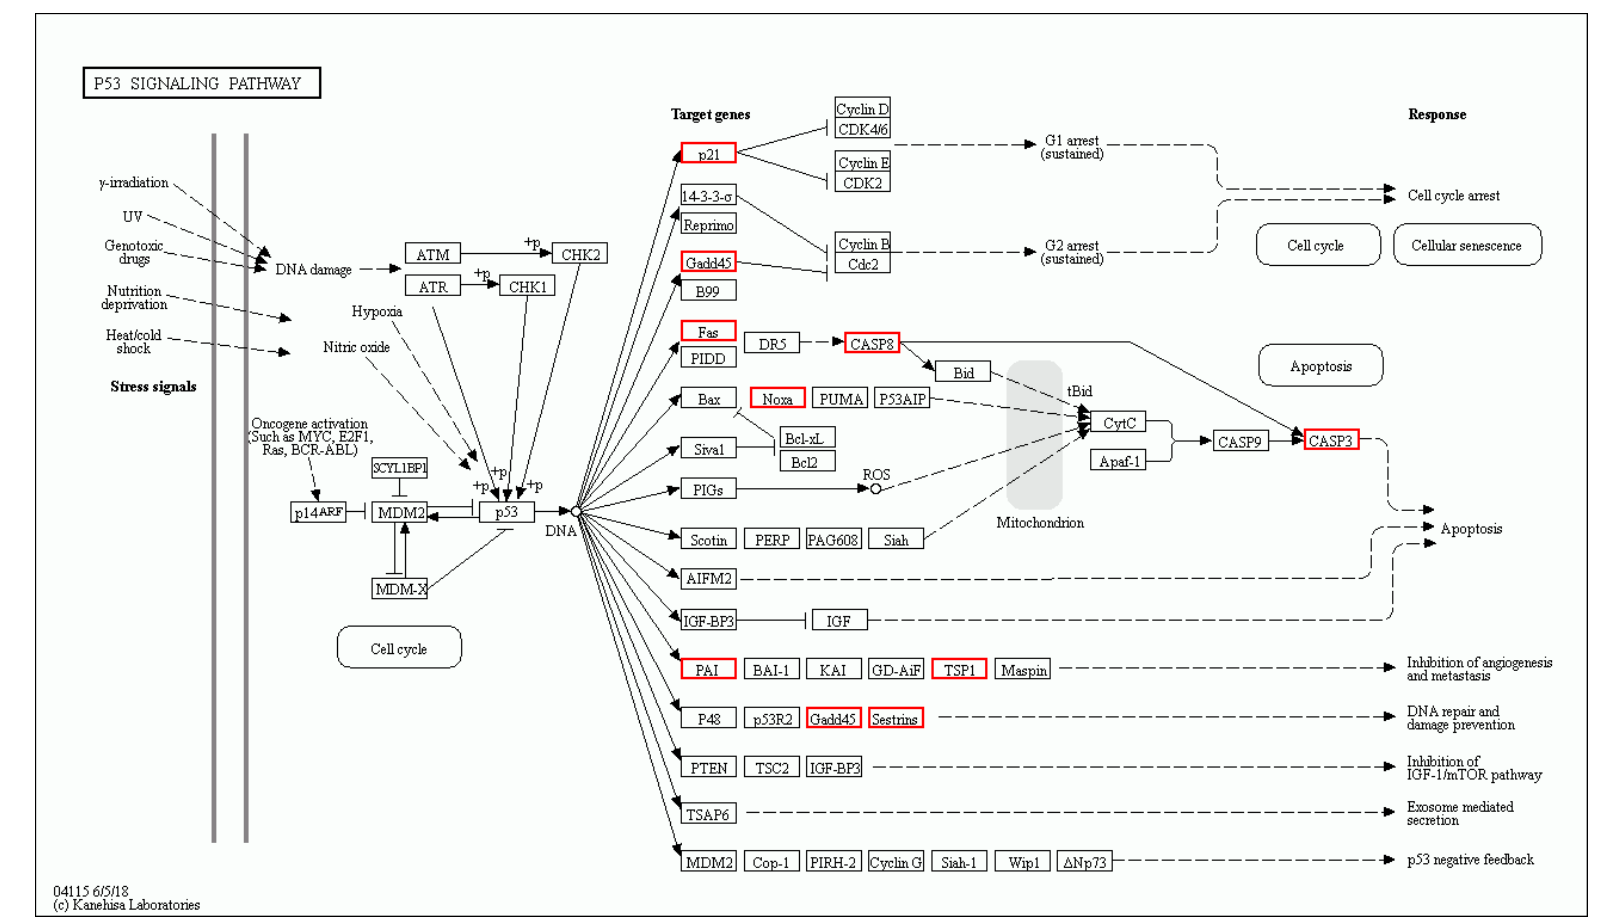
Figure 10. The differentially expressed genes involved in the p53 signaling pathway were annotated by KEGG. The DEGs included cdkn1a , fas, gadd45aa , gadd45ba , gadd45bb , casp3b , casp8l2 , pmaip1 , LOC100535166 , serpine1 , serpinel3 and sesn2 . Red indicates upregulated genes.